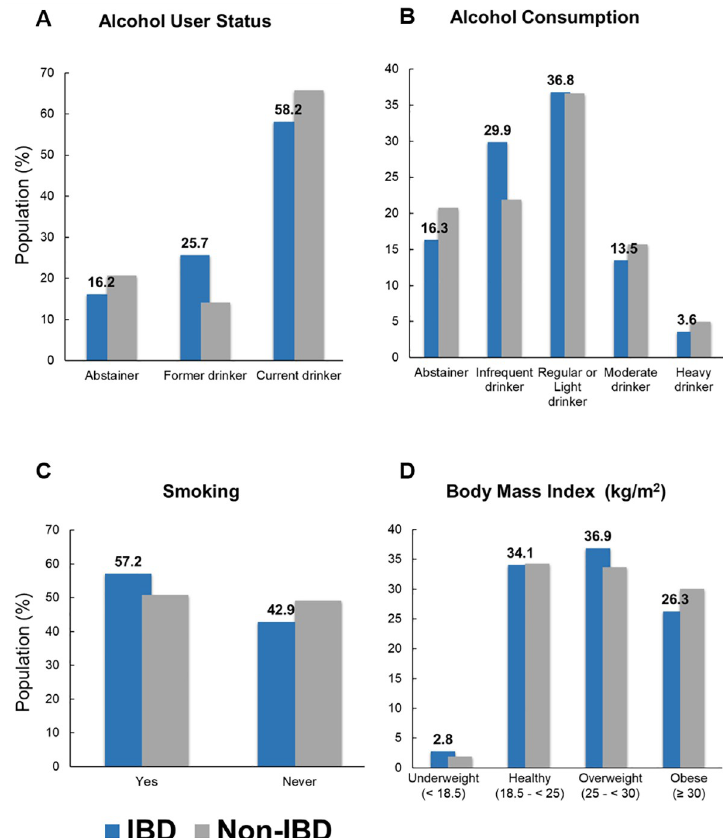
Fig 2. Lifestyle characteristics of estimated US adult population with inflammatory bowel disease (IBD) from National Health Interview Survey (NHIS), 2015. ( A ) Alcohol user status, ( B ) alcohol consumption status, ( C ) smoking, and ( D ) Body Mass Index (BMI, kg/m 2 ). Values in panels A, B, C, and D reflect those of IBD population. Error bars indicate lower and upper bound of 95% confidence interval. N = (Number of people with IBD/Total number) � Asterisks indicate statistically significant difference (p-value < 0.05) when compared to estimated non-IBD population. K-Kindergarten; HS-High school; GED -General Education